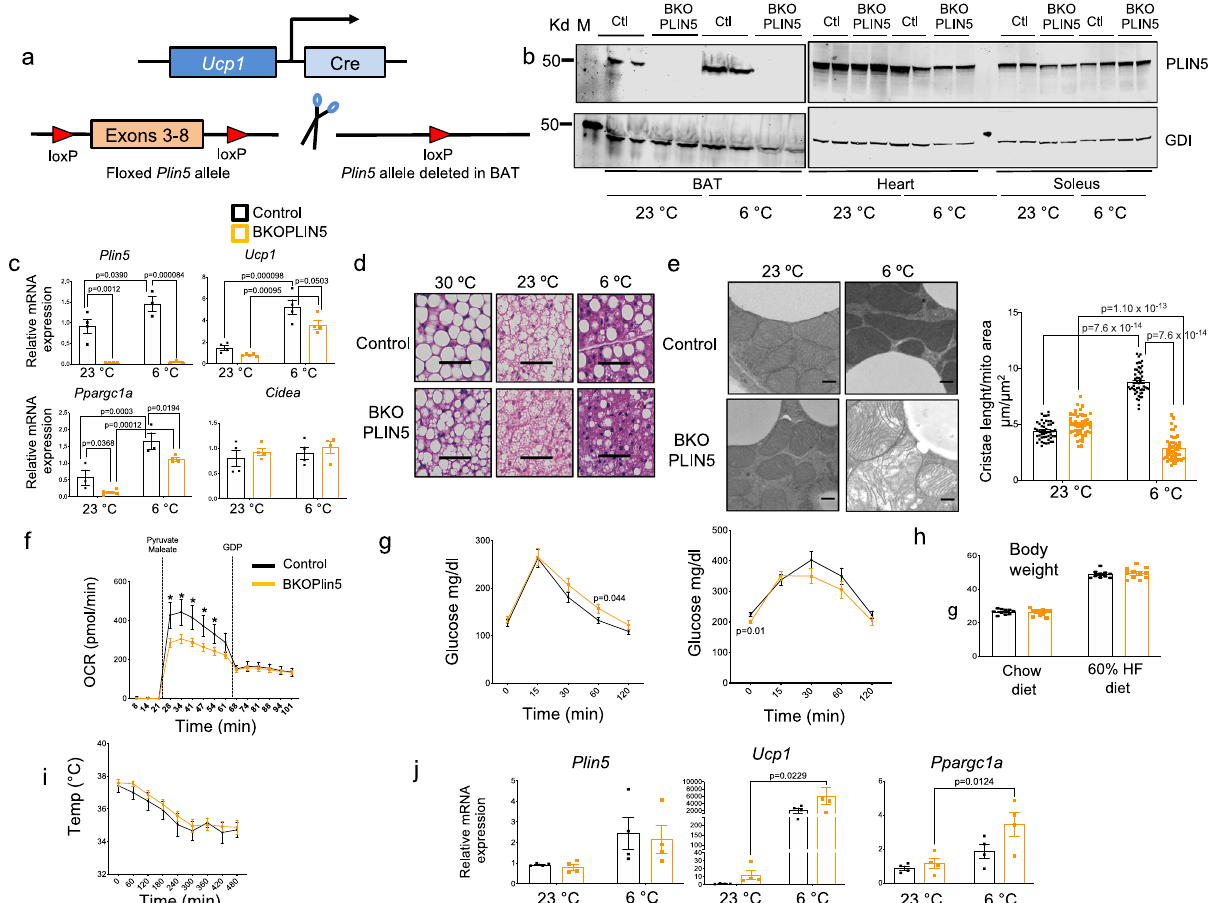
Fig. 7 BAT-speci fi c knockout of Plin5 impairs BAT mitochondrial morphology and respiration but leads to iWAT compensation (data for Control mice are in black and for BKOPLIN5 mice in orange). a Schematic representation of Plin5 gene knockout in BAT (BKOPLIN5 mice). b WB for PLIN5 expression from the indicated tissues of Control or BKOPLIN5 mice housed at 23 °C or exposed to 6 °C for 16 h. c Relative mRNA expression by qPCR for the indicated genes in BAT from Control or BKOPLIN5 mice housed at 23 °C or exposed to 6 °C for 16 h. n = 4 mice per group. d Representative image of hematoxylin and eosin staining of BAT from Control or BKOPLIN5 from mice housed at 23 °C, housed for 7 days at 30 °C or exposed to 6 °C for 16 h. Scale bar = 100 μ m. e Left panel: representative electron microscopy images of BAT from Control or BKOPLIN5 mice housed at 23 °C or exposed to 6 °C for 16 h. Scale bar = 0.5 μ m. Right panel: quanti fi cation of total mitochondria cristae length normalized to mitochondrial area in BAT from Control or BKOPLIN5 mice housed at 23 °C or exposed to 6 °C for 16 h. n = 50 mitochondria/group. f Oxygen consumption rate (OCR) from BAT mitochondria isolated from Control or BKOPLIN5 mice housed at 23 °C after sequential injection of pyruvate/maleate and GDP. n = 3 per group. g OGTT after 8 weeks on chow diet (left panel) or HF diet (right panel). Chow diet Control n = 10, BKOPLIN5 n = 11. h Weight of Control ( n = 10 per group) or BKOPLIN5 ( n = 11 per group) mice fed chow or HF diet for 12 weeks. i Acute cold tolerance test performed on Control ( n = 5 mice) or BKOPLIN5 ( n = 7 mice). j Relative mRNA expression by qPCR for the indicated genes in iWAT from Control or BKOPLIN5 mice housed at 23 °C or exposed 6 °C for 16 h. n = 4 mice per group. Values are mean ± s.e.m. For c , e , and j , statistical analysis was performed using two-way ANOVA followed by Tukey posttest. P values are shown in the fi gure. For f and g , statistical analysis was performed using unpaired two-sided Student ’ s t test. For g and h , p values are shown in the fi gure. For f , p values as follow: *time 28 p